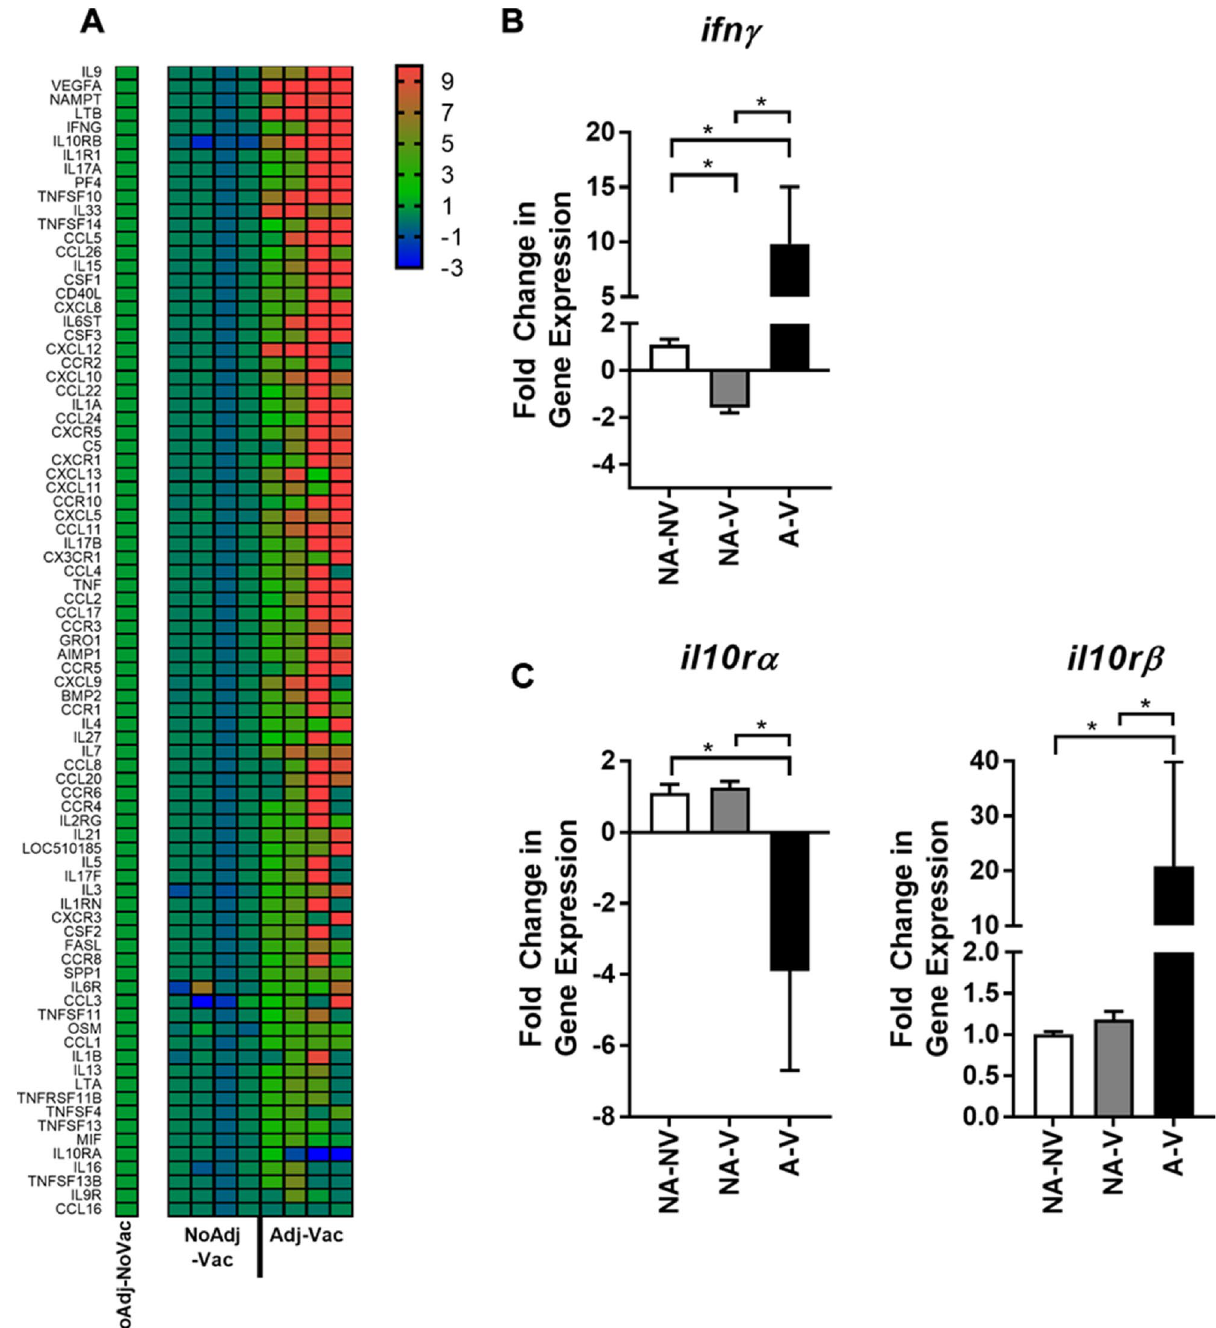
Figure 4. Transcriptional analysis of cells from follicular region of recto-anal junction. Transcriptomic analysis was performed utilizing single-step reverse-transcription quantitative PCR (RT-qPCR) reactions for targets indicated. ( A ) Heat map displays fold change of target genes in non-adjuvanted-vaccinated (NoAdj-Vac; NA-V) and adjuvanted-vaccinated (Adj-Vac; A-V) animals relative to non-vaccinated-non-adjuvanted (NoAdj-NoVac; NA-NV) animals utilizing the 2 −ΔΔCT method. Values were Log 2 transformed to reflect negative fold-change. Red values indicate increased transcript levels, green indicates no change, and blue indicates decreased levels when compared to levels in cells from NoAdj-NoVac group. Each column represents a single animal in the listed treatment group. Values were normalized to 3 housekeeping genes to account for variation in RNA loading. Changes in IFNγ ( B ) and IL10RA and IL10RB ( C ) are shown to highlight a few specific genes. N = 4 per group. Bars = ± SD. One-way ANOVA with Tukey’s post-test was utilized for statistical analysis. * p <